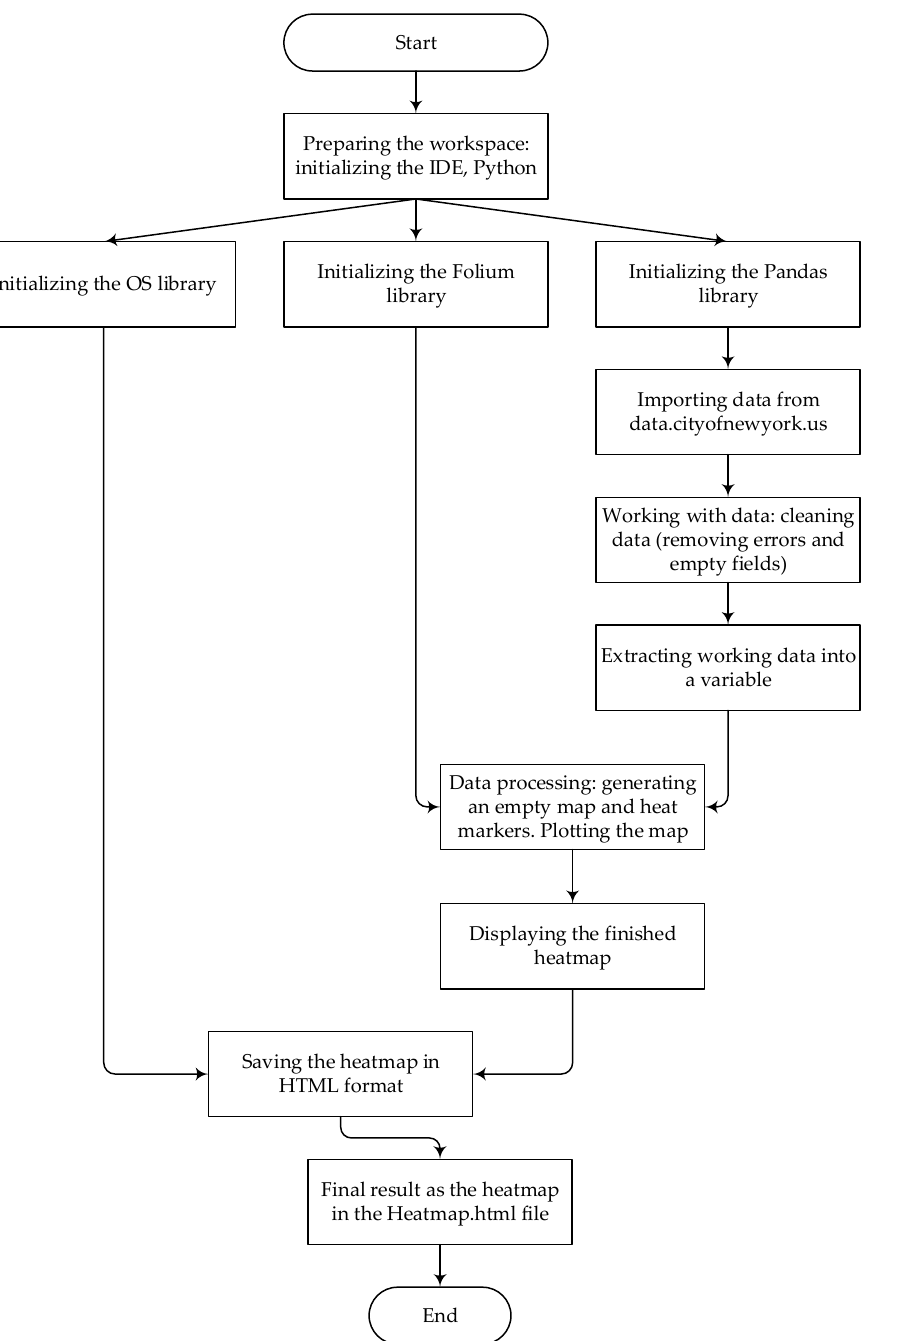
Figure 1. Diagram of the development of an MVTC monitoring system based on a heatmap.